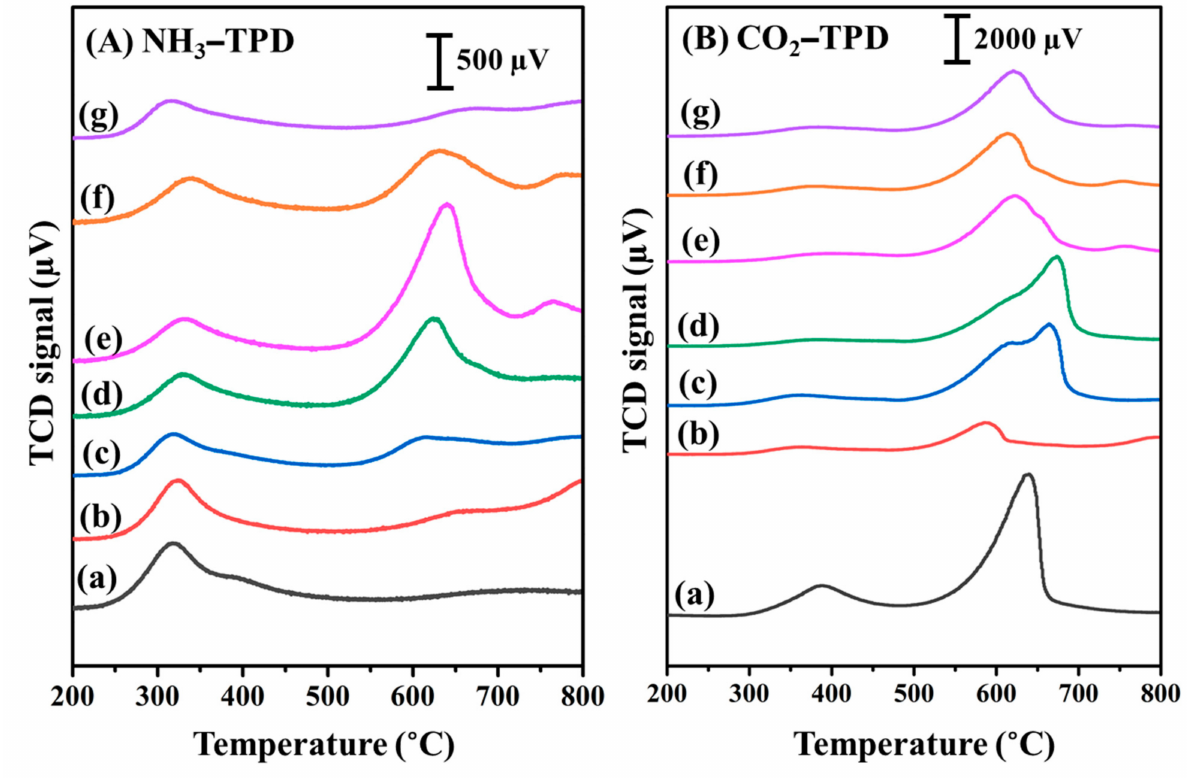
Figure 4. ( A ) NH 3 and ( B ) CO 2 temperature-programmed desorption profiles of reduced (a) CaO sup- port, (b) Cu/CaO, (c) Co 0.49 Cu 1 /CaO, (d) Co 0.96 Cu 1 /CaO, (e) Co 1.40 Cu 1 /CaO, (f) Co 1.94 Cu 1 /CaO, and (g) Co/CaO